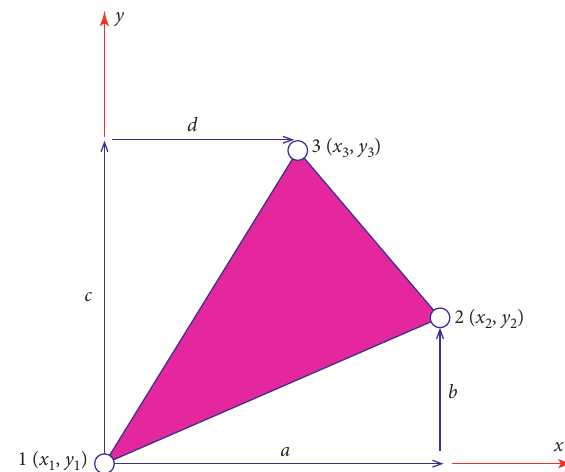
Figure 3: Three-node triangular element in the local